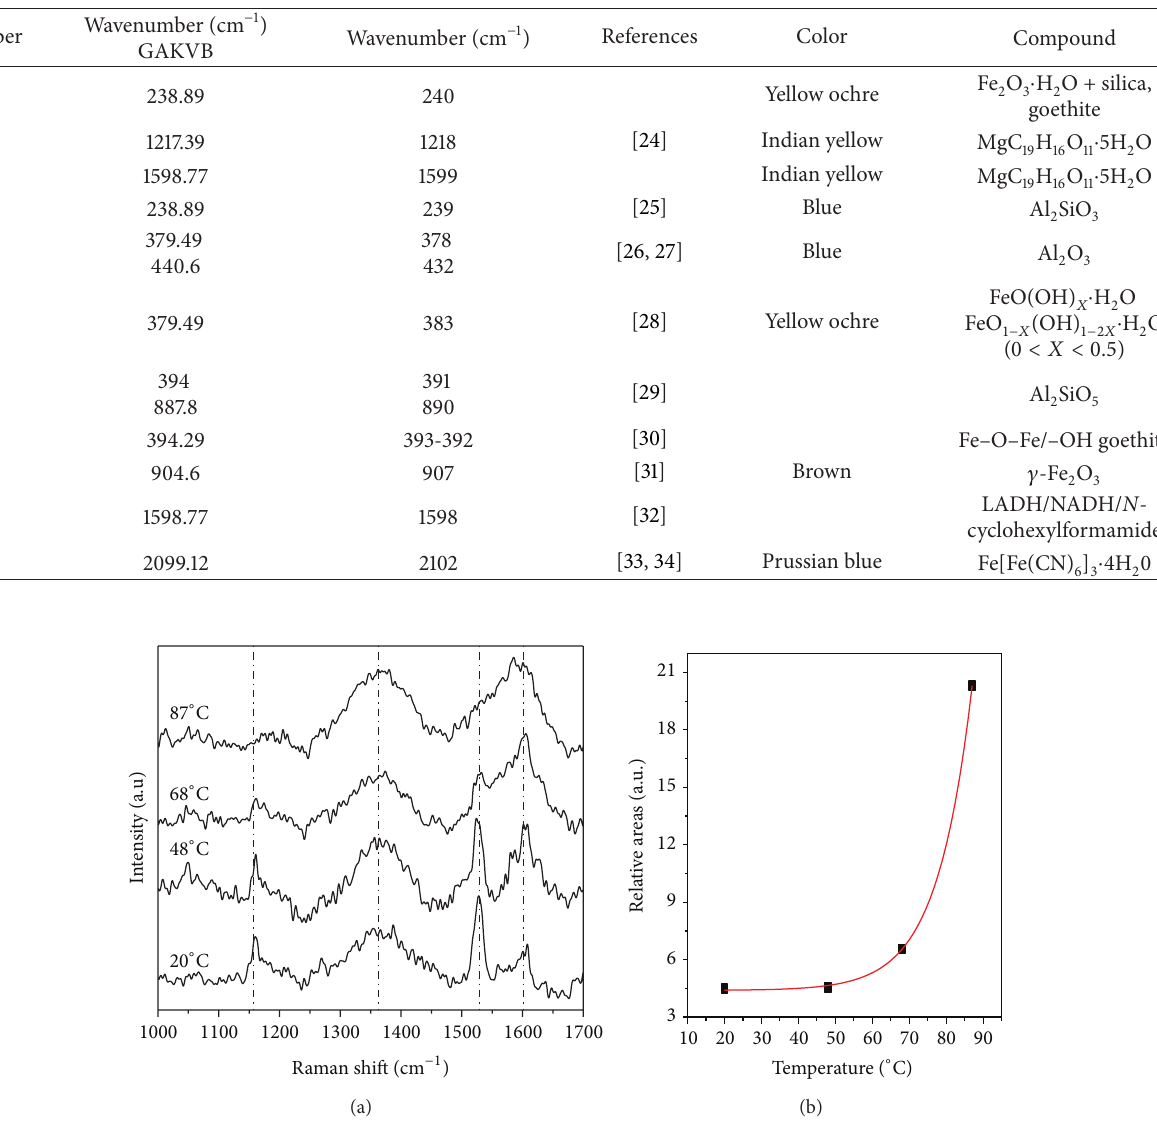
Figure 5: (a) Raman spectra recorded at different temperatures; and obtained on sample surface and (b) relationship between the relative areas of the